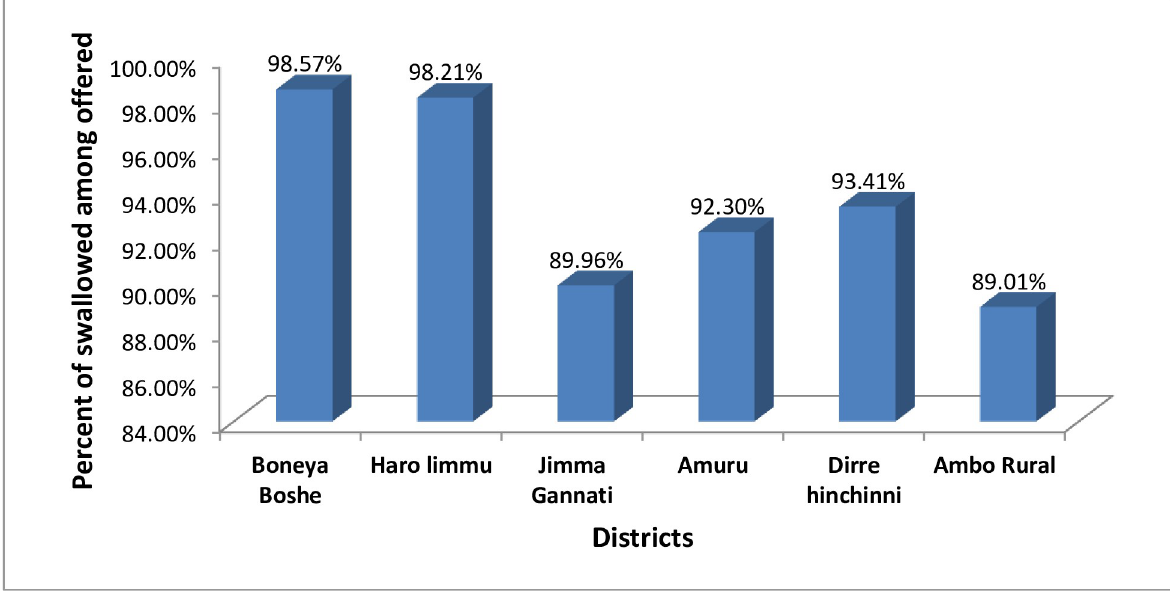
Fig 5. Proportion of people swallowed the drug among those get an offer of the drug in six districts of East Wollega, Horroguduru Wollega, and West Shewa zones,